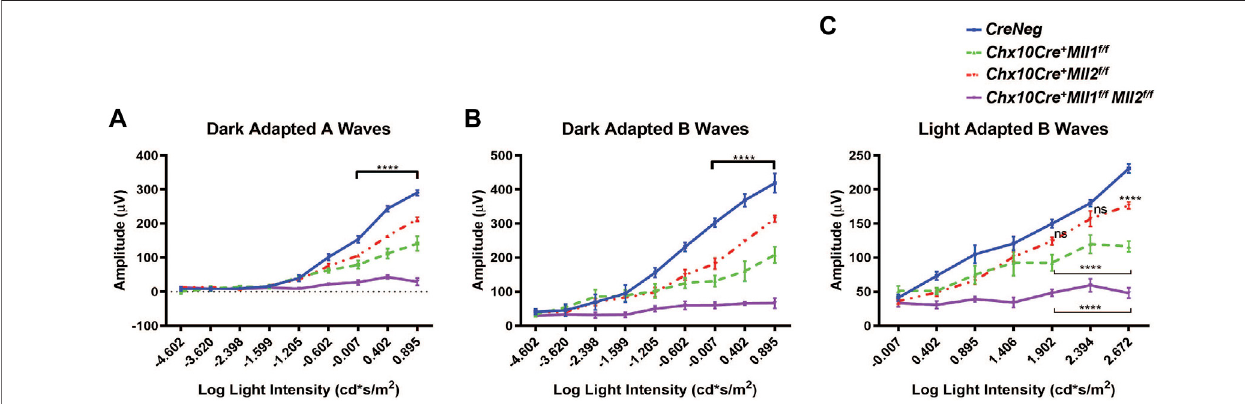
FIGURE 2 | Impaired retinal function of Mll mutants at 1MO. (A) Dark adapted A-wave electroretinogram (ERG) analysis of 1MO mice of the indicated genotypes. Mean amplitudes (µV) are plotted against stimulus light intensity. Error bars represent SEM ( n ≥ 4). (B) Dark adapted B-wave ERG analysis of 1MO mutant and control